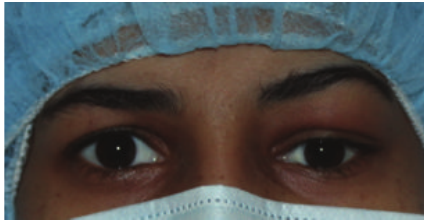
Figure 1: Photographic image of the patient showing the left periorbital swelling.